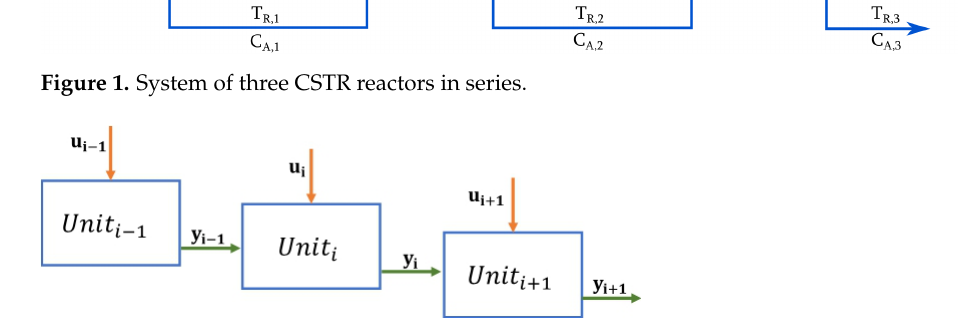
Figure 2. Serial process block diagram for